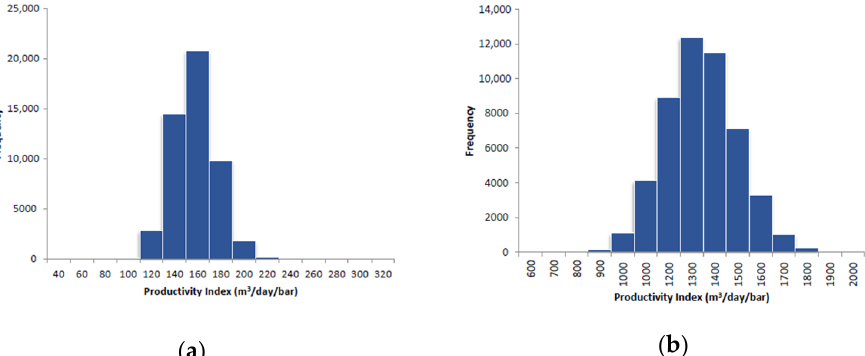
Figure 8. Productivity index distribution—Drava ( a ) and Sava ( b ) Depression—syn-rift phase.